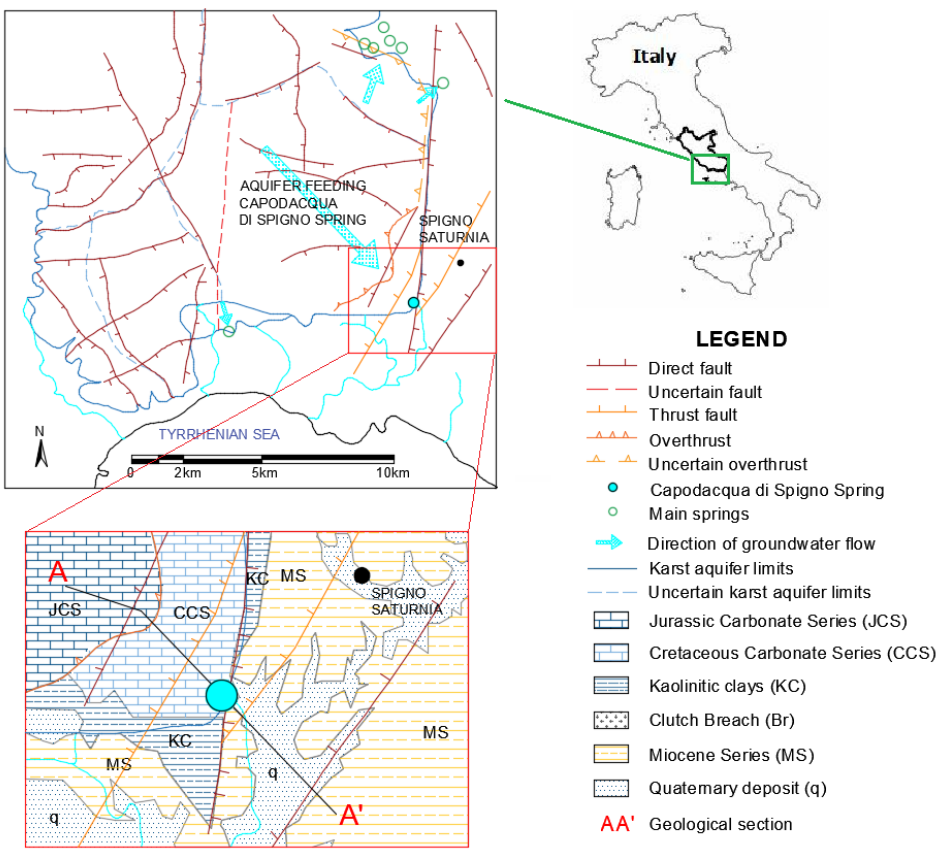
Figure 1. Structural map and main groundwater flow direction of Capodacqua di Spigno Spring (up); excerpt of the geological map and positioning of the geological section AA’ represented in Figure 3 (down)—based on Baldi et al., 2005 [28].